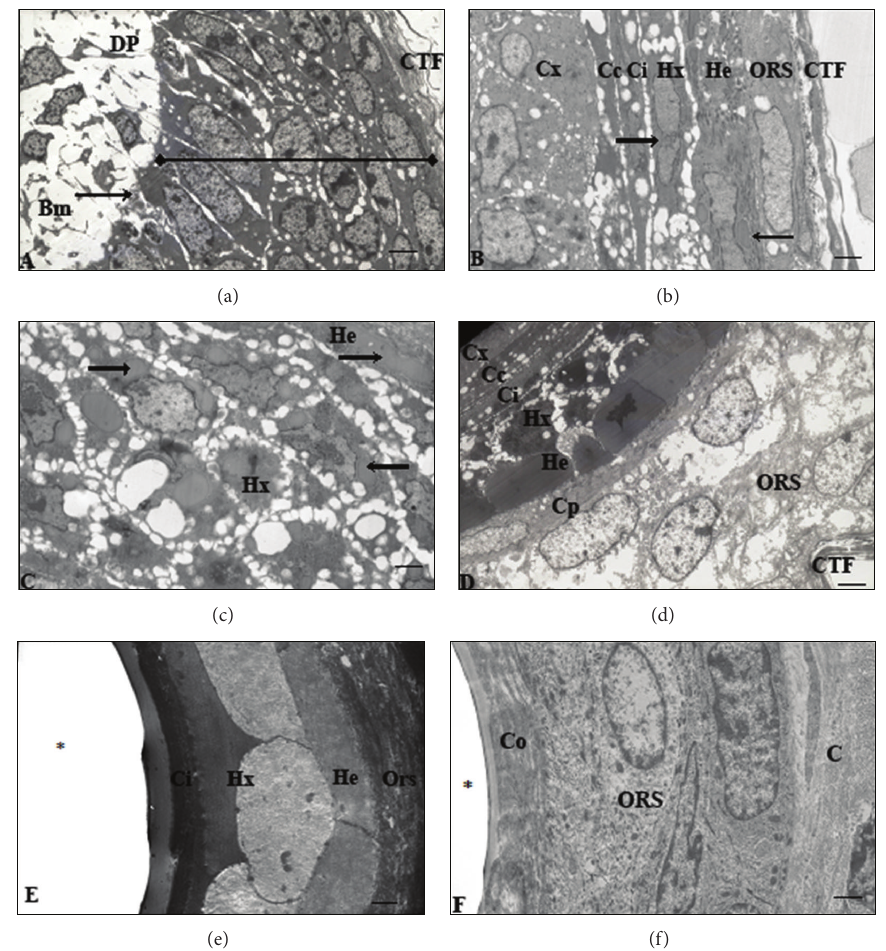
Figure 6: Electron micrographs of hair follicles from young adult four-striped mouse skin. (a) and (b) correspond to Figures 5(a) and 5(b) at the hair bulb and suprabulbar levels. Trichohyalin granules (arrows) are seen in the Huxley and Henle layers. (c) is at the suprabulbar level showing an accumulation of cells in Huxley’s layer in the superior aspect of the follicle and corresponds to Figure 5(c). (d) is a section slightly higher than suprabulbar level and corresponds to Figure 5(d). Henle’s layer and the inner root sheath are keratinised. (e) is a section of hair follicle layers at the superficial hypodermis to basal dermis and corresponds to Figure 5(e). The inner root sheath is fully keratinised in (f) above the level of the sebaceous gland and corresponds to Figure 5(f). Bm: basement membrane; C: collagen fibres; Cc: cuticle of cortex; Ci: cuticle of inner root sheath; Co: cornified cellular layer; Cp: companion layer; CTF: connective tissue follicle; Cx: cortex; DP: dermal papilla; He: Henle Layer; Hx: Huxley layer; ORS: outer root sheath; Line ; hair matrix; Asterisk ; area of missing hair shaft. Scale bar: (a) and (d), 0.5 𝜇 m; (b) and (c), 0.33 𝜇 m, (e), 0.25 𝜇 m and (f), 0.20 𝜇